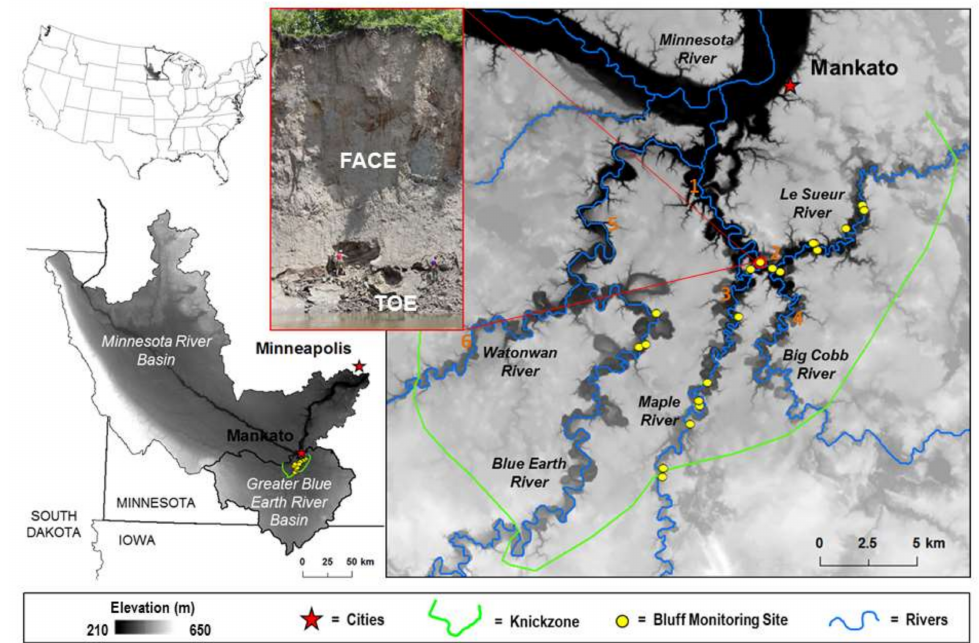
Figure 1. Locations of bluff study sites within the Greater Blue Earth River basin. Inset photo corresponds with bluff site LS10, a 20-m-tall bluff composed of overly consolidated glacial till; 1.8-m-tall person for scale. Streamflow gages are labeled by number (1: Le Sueur River gage near Rapidan, MN (USGS 5320500), 2: Le Sueur River near Highway 8 (MPCA/MDNR site 32076001), 3: Maple River at Highway 35 (MPCA/MDNR site 32072001), 4: Big Cobb River near Beauford (MPCA/MDNR site 32071001), 5: Blue Earth River near Rapidan (USGS 05320000), 6: Watonwan River near Garden City (MPCA/MDNR site 31051001)). Photo taken following a large flood event in June 2014 (credit: Shayler